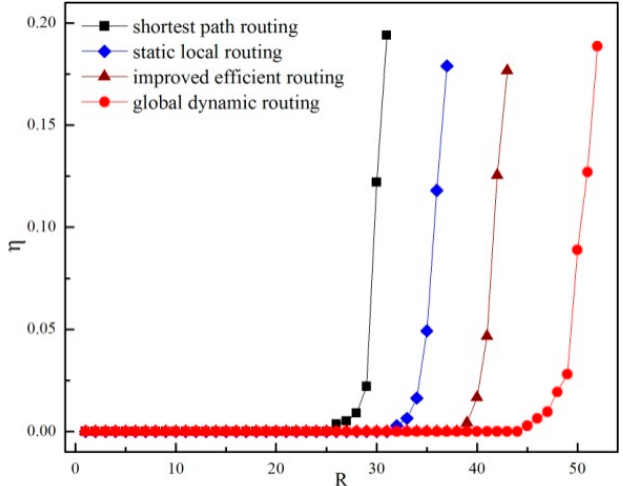
Figure 11. The order parameter η vs. R under the four routing strategies.